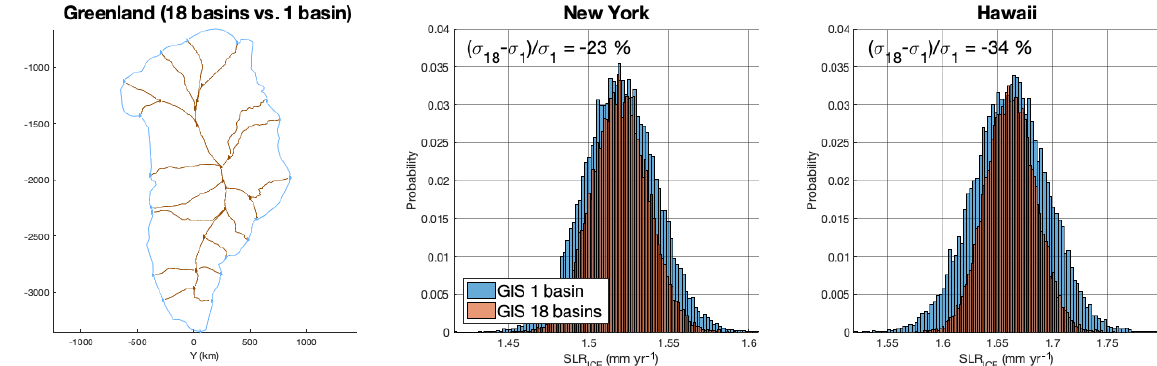
Figure 12. Impact of subsampling the GIS mass (from 1 basin for the whole ice sheet to 18 basins) on barystatic sea-level rise in New York and Hawaii. The distributions are a result of SLPS, where H GIS , H AIS and H GLA were sampled 10000 times using an LHS algorithm. The means in PDF distributions for both scenarios are identical; however, the tails are much larger for the one-basin scenario. The relative difference in standard deviations between 1 and 18 basins ranges from − 23% for New York to − 34% for Hawaii. This implies that current probabilistic RSL projections could significantly overestimate (20%–30%) the “likely” (5%–95%) range in ice-melt contribution from glaciers and ice